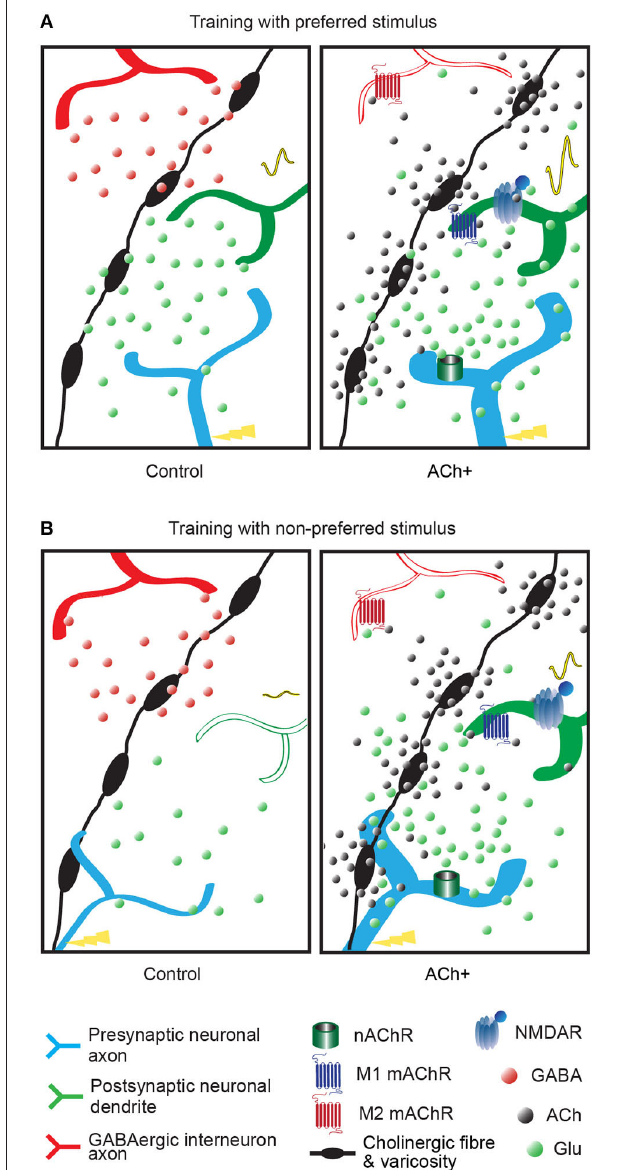
FIGURE 4 | Summary of the effect of acetylcholine on neuronal transmission of the visual inputs . The varicose cholinergic fiber (black fiber with swellings) can act on excitatory input (blue axon), neighboring GABAergic inhibitory input (red axon) and on V1 neurons (green dendrite). Excitatory/inhibitory influences are represented by red and green dots, respectively. Cholinergic activation (ACh+, right panel) is represented by black dots. The cortical response to the stimulus is represented by a VEP signal waveform which changes are elicited by increased numbers of neurons responding to the trained stimulus or increased neurons efficiency. (A) Response of the V1 neuron after a training with preferred stimulus coupled to cholinergic activation (right panel, ACh+) or without (left panel, control). The cortical response to this stimulus is increased (high VEP signal waveform in right panel compared to small VEP signal waveform in left panel). In presence of cholinergic activation the inhibitory influence is reduced by M2 muscarinic receptors (mAChRs), the postsynaptic excitatory influence is increased by M1 mAChRs located on the postsynaptic